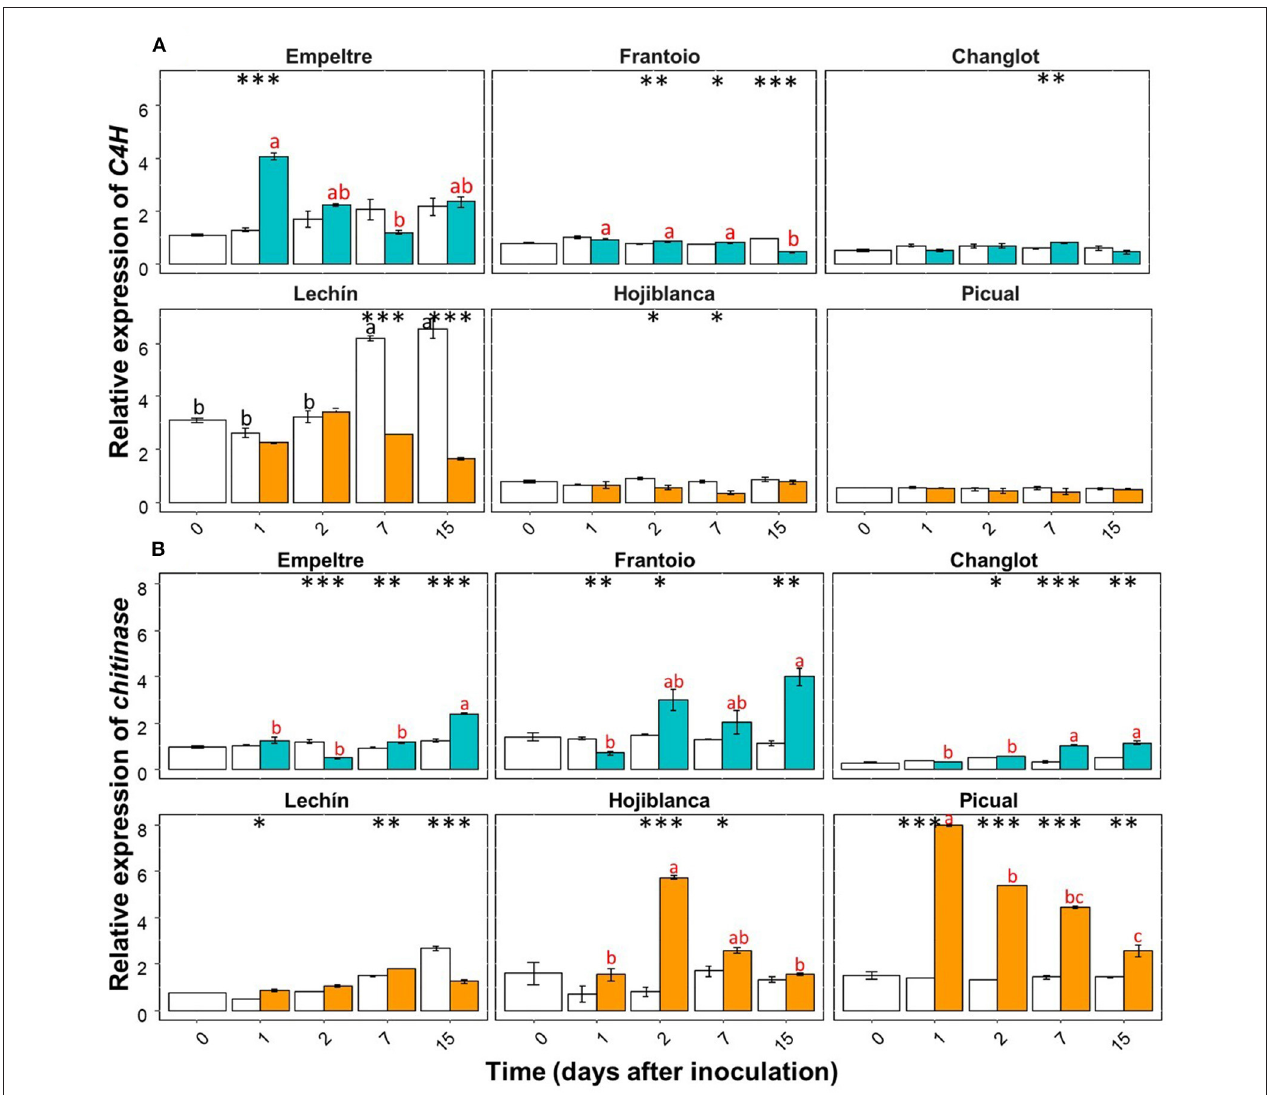
FIGURE 5 | Time course of the relative expression of C4H (A) and CO-MT (B) genes. Control (non-inoculated) plants are represented in white color while Verticillium dahliae -inoculated plants are shown in light blue color (tolerant cultivars) or in orange color (susceptible varieties). The error bar corresponds to the standard deviation (SD) from the mean of the three biological replicates. Tukey’s post hoc test differences ( p < 0.05) are represented in black letters among the control plants and in red letters among the inoculated plants. The statistical differences resulted by the ANOVA analysis between the control and inoculated plants are represented by asterisks (level of significance: *, p < 0.05; **, p < 0.01; ***, p <